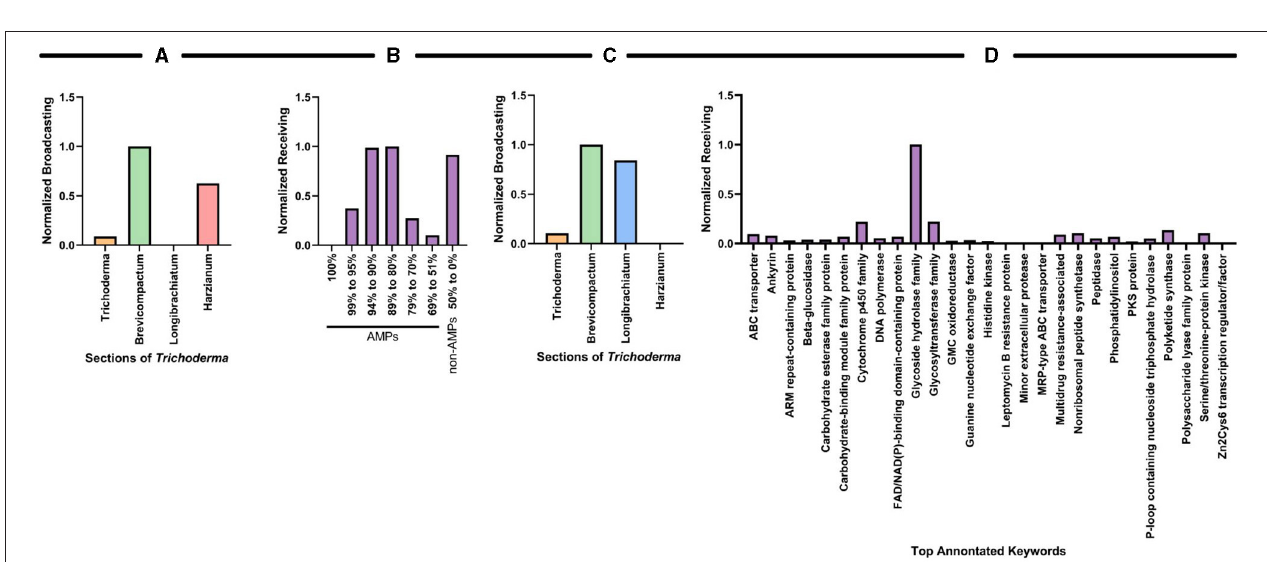
FIGURE 9 | Graph theoretical analysis to characterize influential species sections of Trichoderma based on their probability of having AMP-related genes and keyword protein annotations. The PageRank measure for the sections with respect to the probable AMP-related gene are quantified by the normalized (A) broadcasting and (B) receiving values, respectively. The PageRank measure for the sections with respect to the keyword proteins are quantified by the normalized (C) broadcasting and (D) receiving values, respectively.